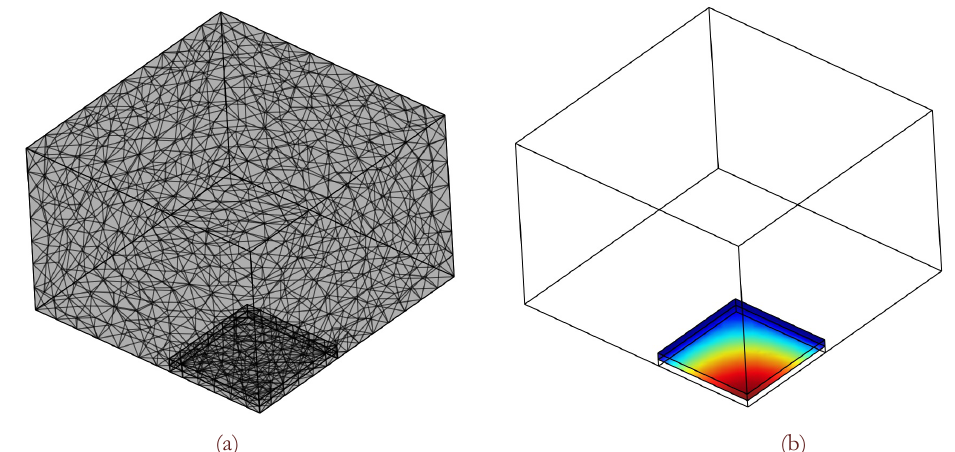
Figure 1: Mesh of tetrahedral elements (a) and pressure field under one fourth of the moving plate